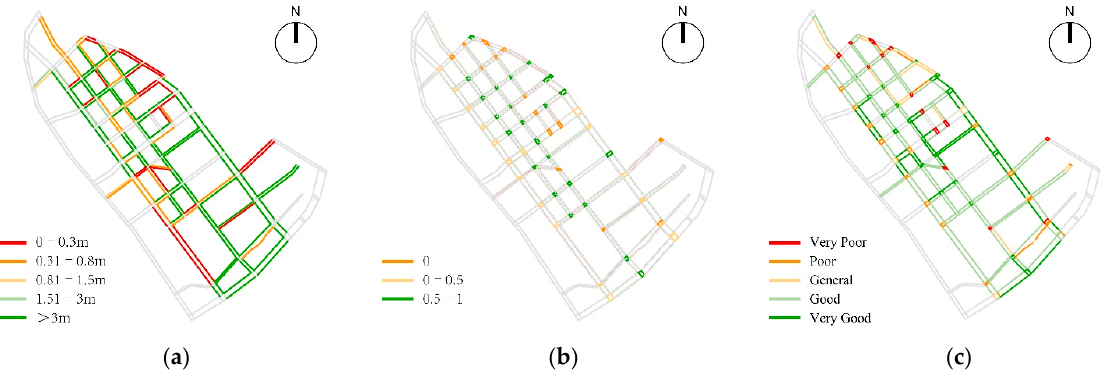
Figure 13. The analysis of pedestrian space safety: ( a ) the Obstruction of Pedestrian Safety; ( b ) the Completeness of Crossing Facilities; ( c ) the Impact Degree of Traffic Flow.